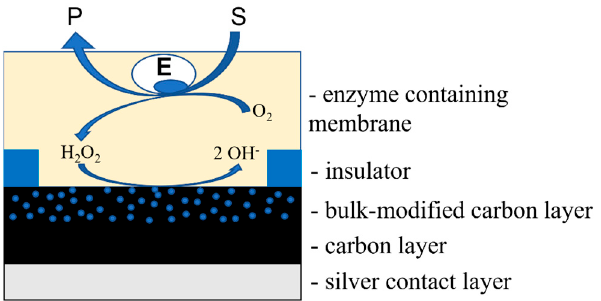
Figure 5. The construction scheme and functioning of the biosensor system made through the single printing step of carbon ink containing PBNPs.